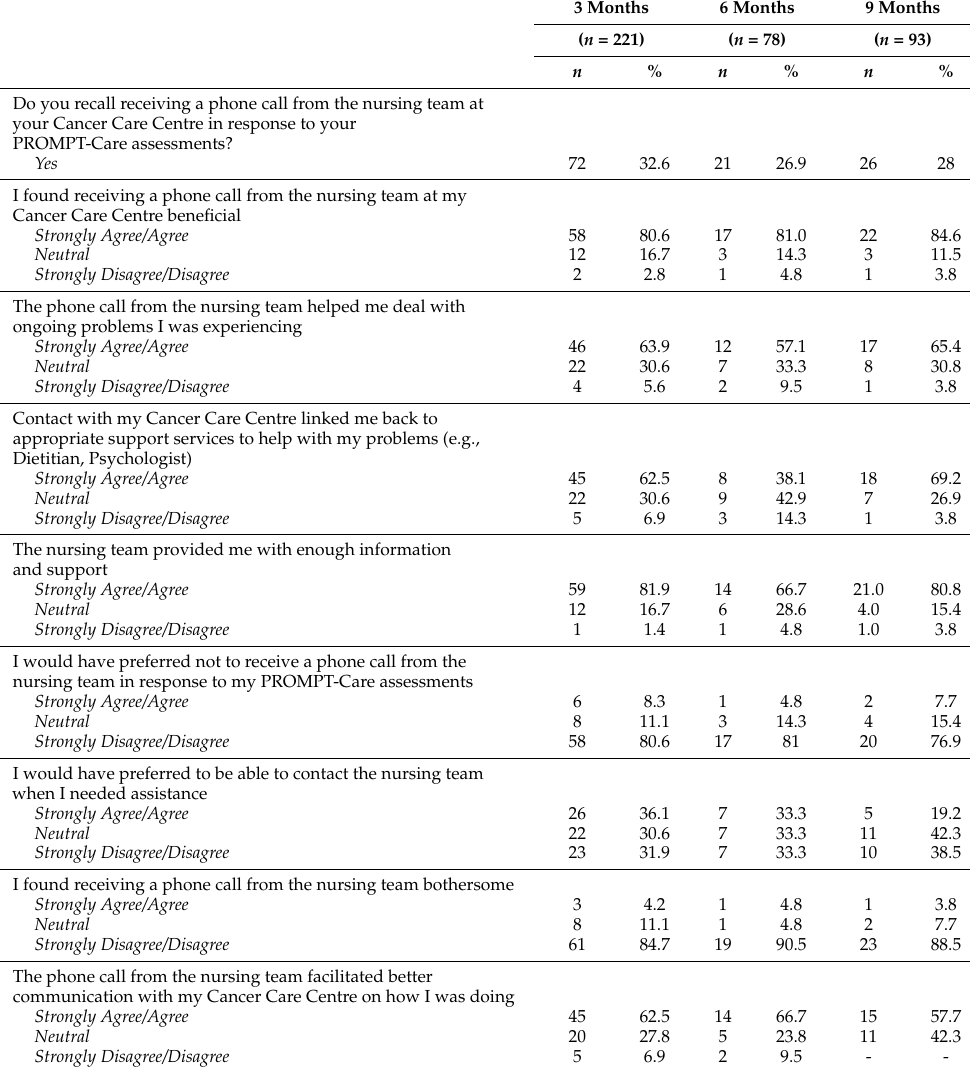
Table 3. Evaluation survey